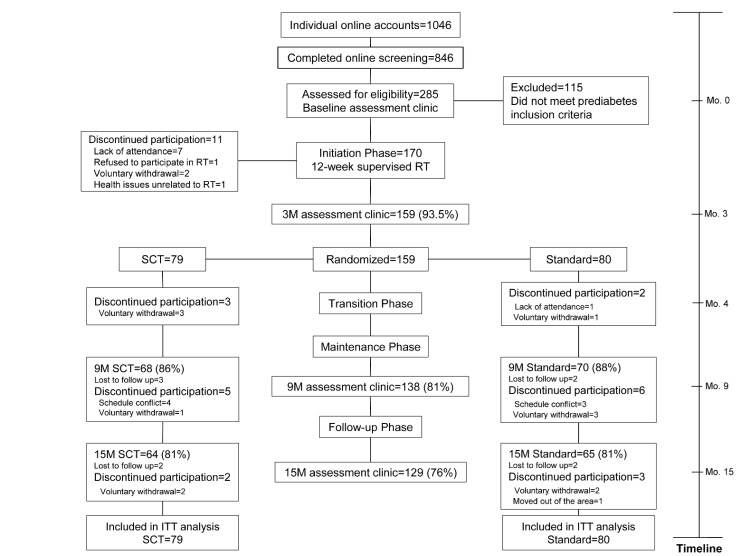
Resist Diabetes study consort diagram.Abbreviations: RT = resistance training; 3M = 3-month; SCT = social cognitive theory group; 9M = 9-month; 15M = 15-month; ITT = intent-to-treat.